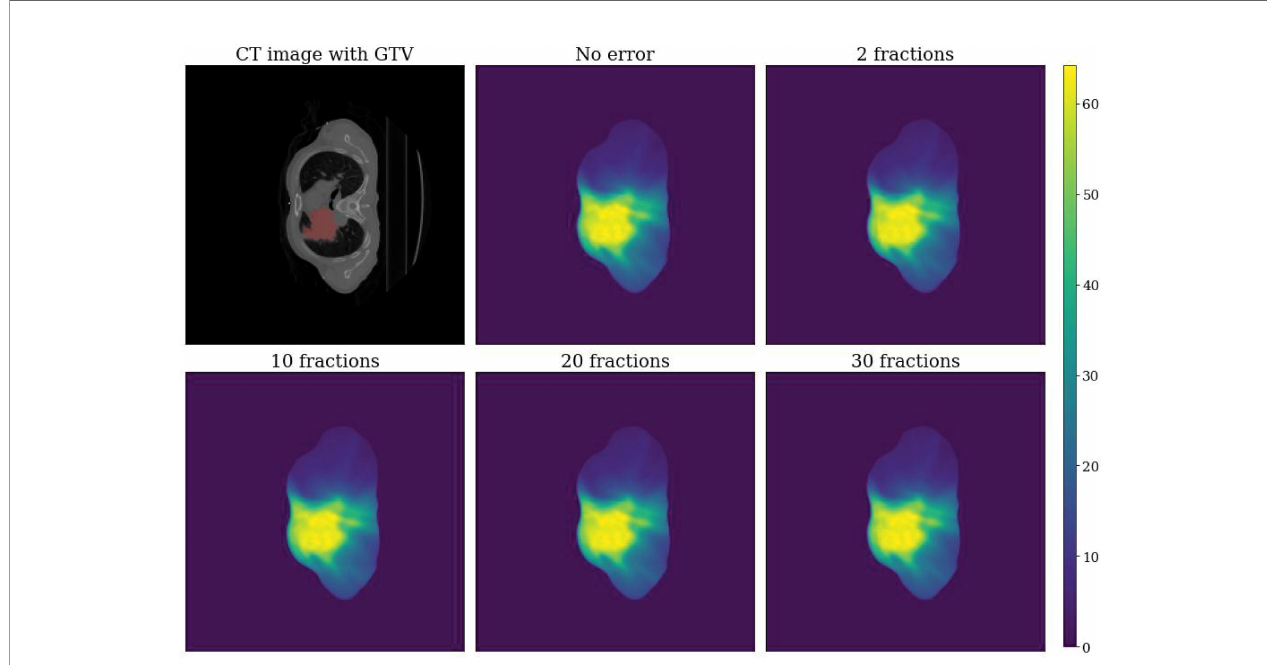
FIGURE 1 | Example dose distributions for patient 9. Top left: CT image with GTV label. Top center: Dose distribution without error (D ori ). Top right: Dose distribution with error for a total of two fractions. Bottom left: Dose distribution with error for a total of 10 fractions. Bottom center: Dose distribution with error for a total of 20 fractions. Bottom right: Dose distribution with error for a total of 30